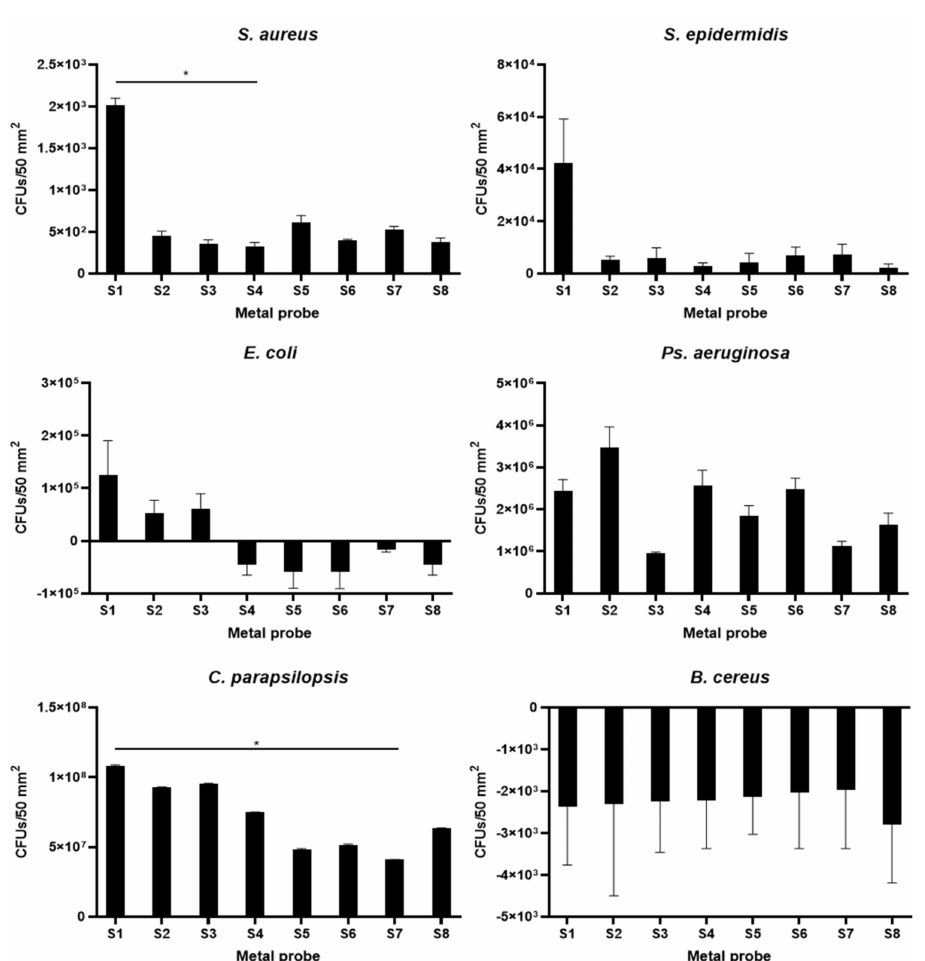
Figure 9. CFU values obtained after the biofilm assays on the 8 different types of metal probes: ( a ) S. aureus , ( b ) S. epidermidis, ( c ) E. coli , ( d ) Ps. aeruginosa , ( e ) C. parapsilosis , ( f ) B. cereus . Statistically significant differences (ANOVA test, p -value < 0.05) are marked with an asterisk: p -value for S. aureus S1–S4 comparison is 0.0440, p -value for C. parapsilosis S1–S7 comparison is